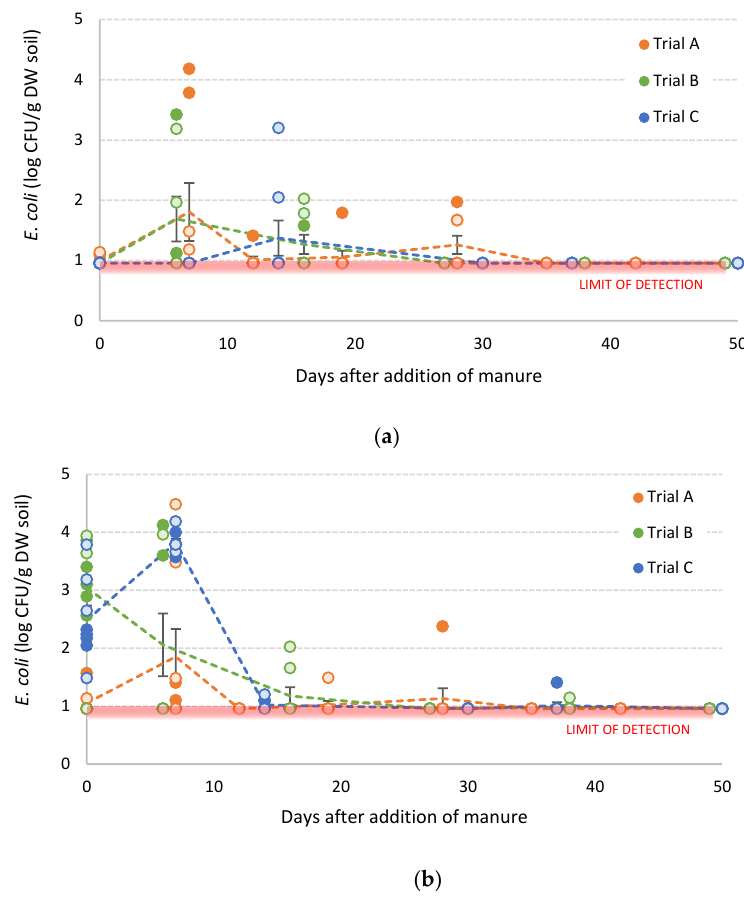
Figure 3. Populations of E. coli in sandy ( ) and clay loam ( ) soil amended with ( a ) poultry litter or ( b ) poultry litter inoculated with E. coli and S. sofia. Each point represents a test result (4 points/sampling time/soil type/trial). Dashed lines indicate the mean for each dataset; bars indicate the standard error of mean values.